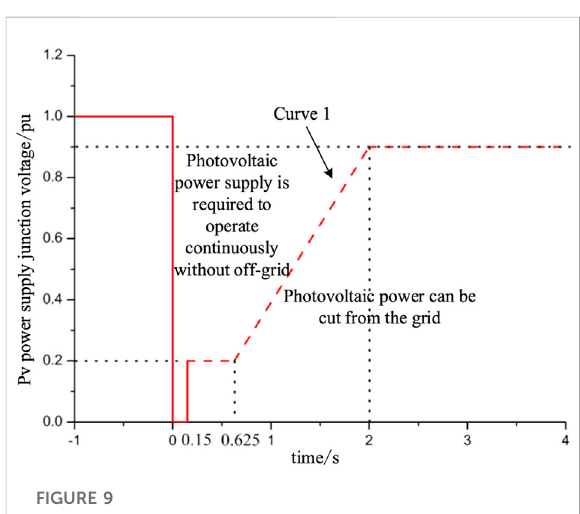
FIGURE 9 Low voltage traversal capability of distributed power